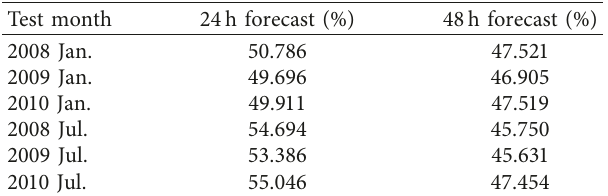
Figure 2: 24h nonsystematic error of geopotential height on 500hPa (unit: gpm) (a) January 17, 2008; (b) July 26, 2009; (c) January 15, 2010; (d) July 24, 2010. Table 1: Proportion of nonsystematic error in total forecast error of geopotential height on 500hPa.